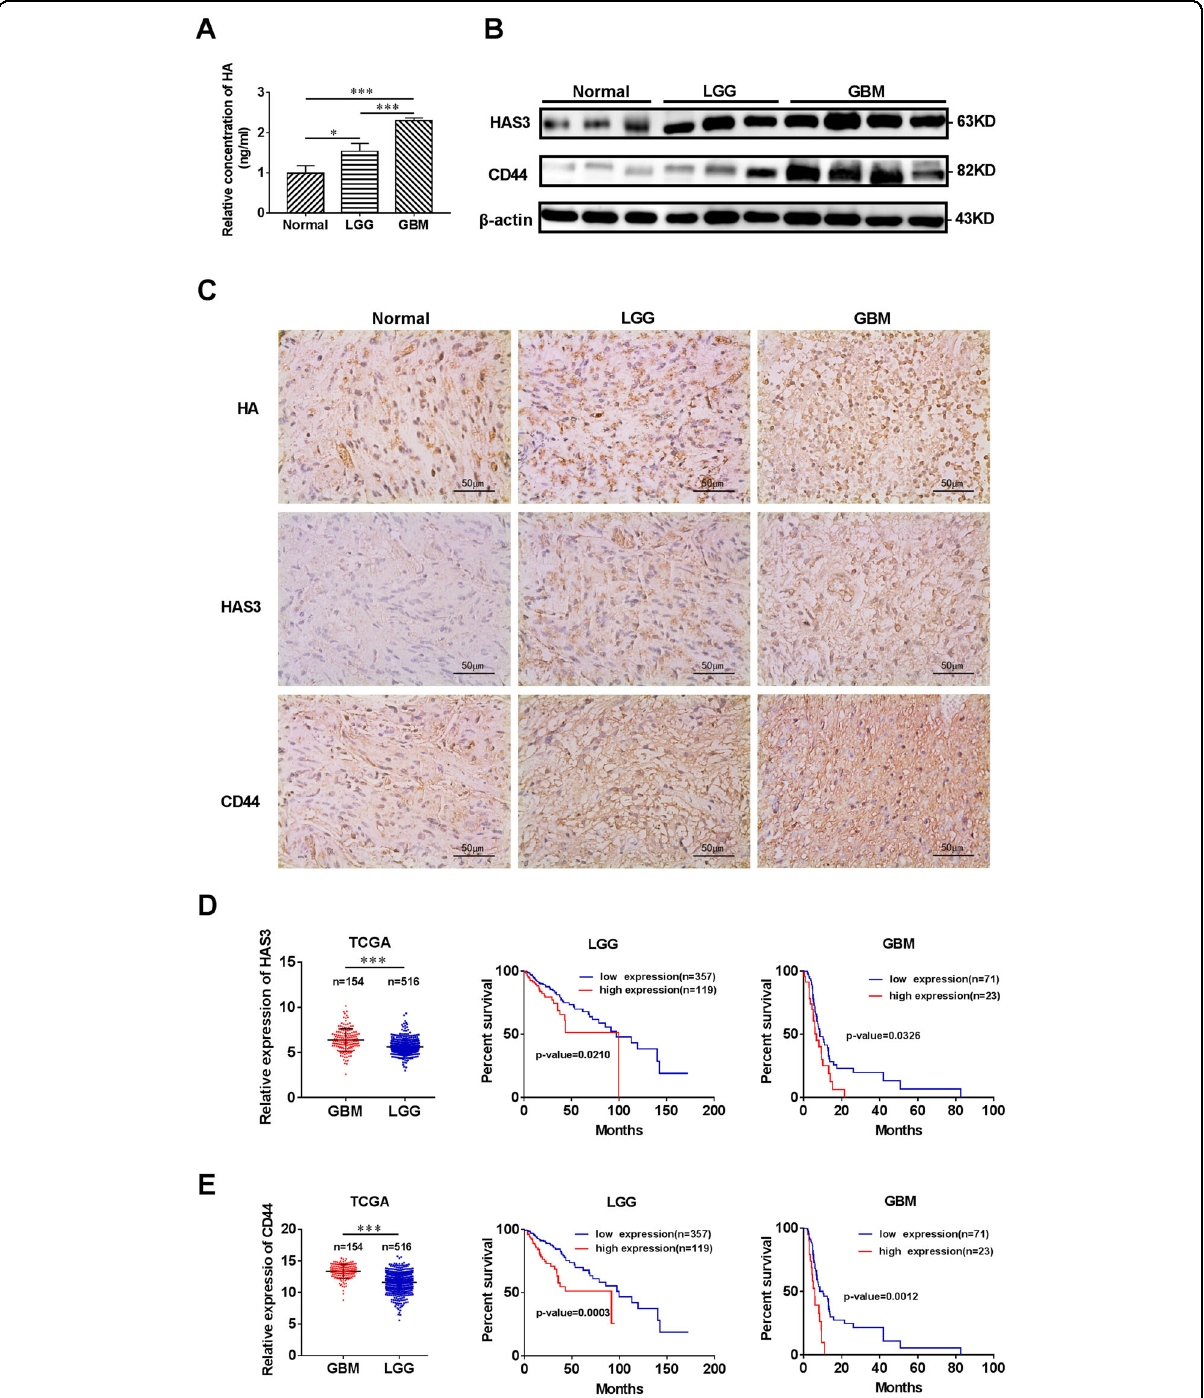
Fig. 1 Hyaluronic acid, HAS3, and CD44 are increased in glioma tissues and negatively correlated with the prognosis of glioma. A Relative concentration of HA in human glioma tissues of different grades and normal brain tissues by ELISA. B Representative images of IHC staining for HA, HAS3, and CD44 in human glioma tissues of different grades and normal brain tissues. Scale bar: 50 μ m. C Relative levels of the HAS3 and CD44 proteins in human glioma tissues of different grades and normal brain tissues. D – E Relative expression of HAS3 and CD44 mRNA in patients with LGG and GBM from TCGA. Survival curves of HAS3 and CD44 for patients with LGG and GBM from TCGA database. The data are presented as the mean ± SD; * P < 0.05, ** P < 0.01, and *** P < 0.001, **** P <